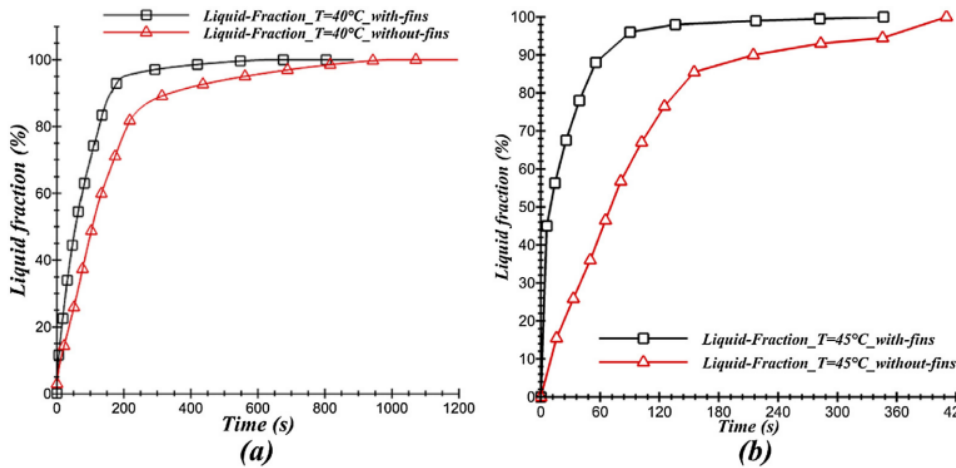
Figure 9. Development of liquid fraction of the studied configurations for ( a ) T h = 40 °C and ( b ) T h = 45 °C. Reprinted with permission from Ref. [22]. 2018, Elsevier.